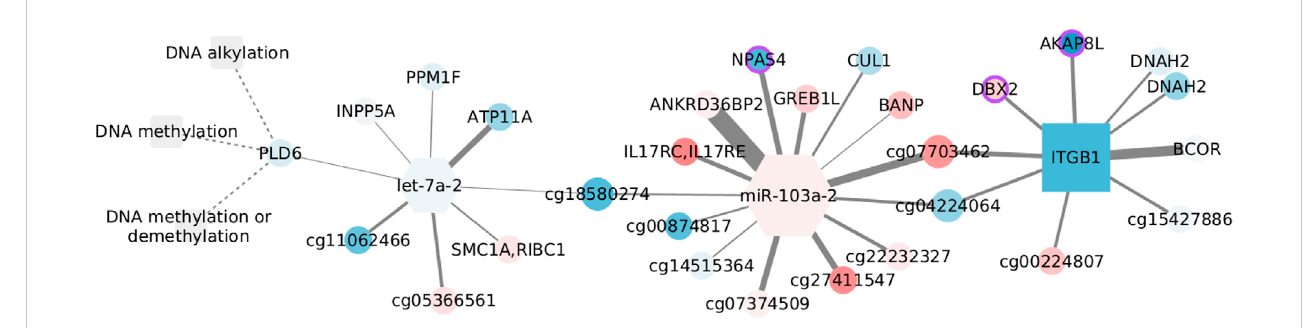
FIGURE 8 Features connected with DNA methylation in the normal adjacent tissue. Color corresponds to log fold changes in the basal